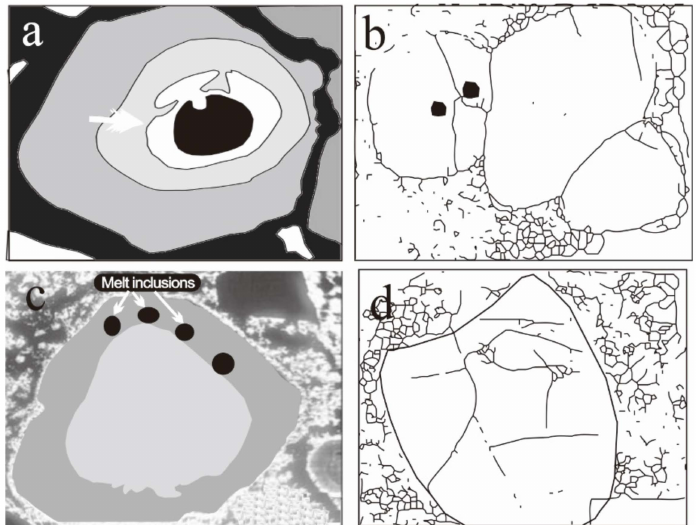
Figure 4. Sketches of SEM-CL images of quartz phenocryst. ( a ) Phenocryst with a resorbed crystal core and bright overgrowth (white arrow). ( b ) Zoned phenocrysts with melt inclusions. ( c ) Resorption episode followed by irregular growth, which results in the entrapment of melt inclusions (MIs). ( d ) Rounded (resorbed) quartz phenocryst with blurred internal growth zoning (modified from